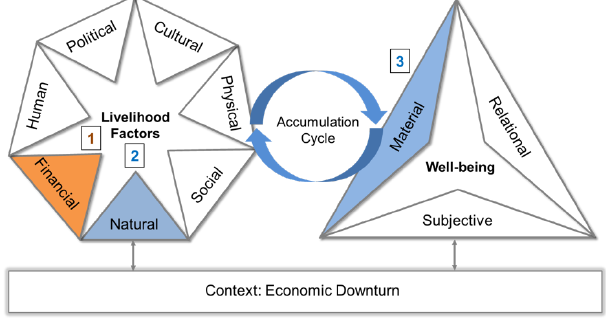
Fig. 6 . The integrated sustainable livelihoods approach and well-being framework for northeastern Colorado livestock producers illustrating a strategy of expansion when challenged, with orange depicting losses and blue indicating elements that gained or maintained. (1) First, the economic downturn in the 1980s left the producer unable to sell out. (2) In response to financial challenges and limited access to other livelihood strategies, the producer invested in acreage when the market was low. (3) Because of their ability to increase property despite challenges with financial institutions, the producer maintained their industry through the 1980s downturn, and today, they are a largescale operator.